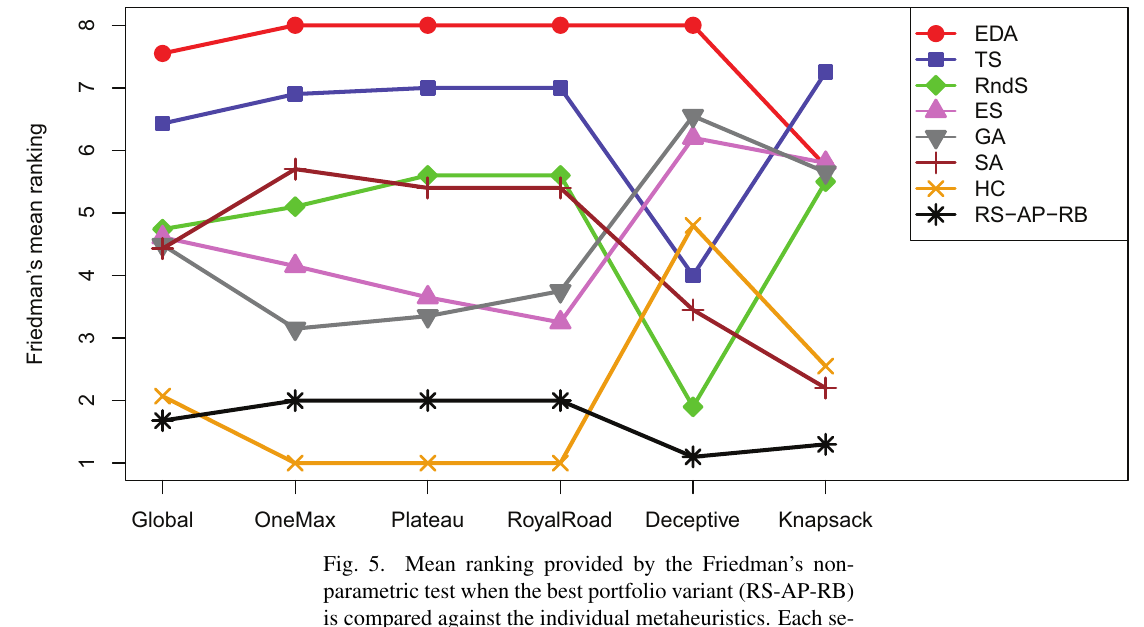
Fig. 5. Mean ranking provided by the Friedman’s non- parametric test when the best portfolio variant (RS-AP-RB) is compared against the individual metaheuristics. Each se- ries represent the mean raking (Y axis) for a method when all problems are considered (Global) and for each problem (OneMax, Plateau, RoyalRoad, Deceptive and